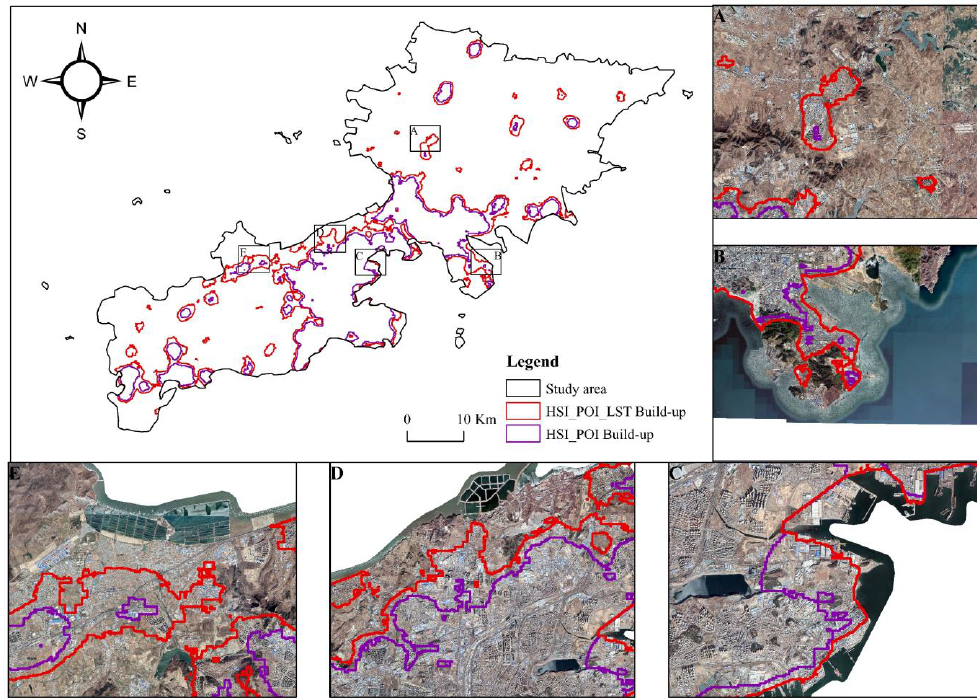
Figure 9. Comparison of the HP index and HPL index identifying the boundary of the built-up area. Area ( A ) an industrial park. Area ( B ) Dayaowan Free Trade Zone. Area ( C ) comprises several petrochemical companies. Area ( D , E ): situated at the junction between urban and rural areas. Area ( D ) logistics company. Area ( E ) an industrial park.